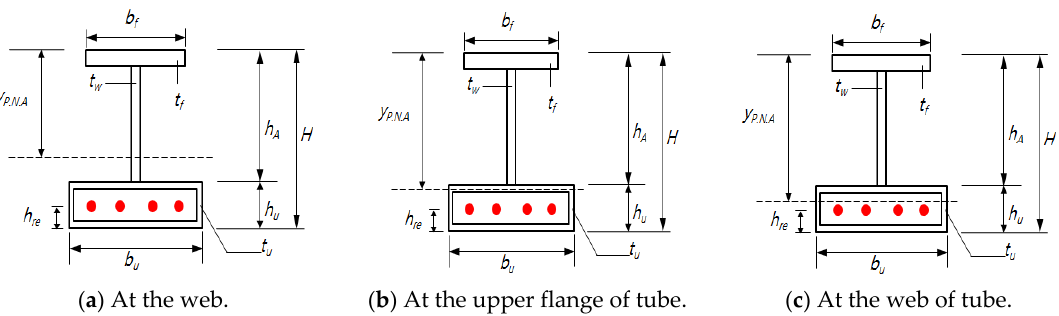
Figure 9. Locations of plastic neutral axis for the non-composite specimen without web openings. (1) In case the plastic neutral axis exists at the web